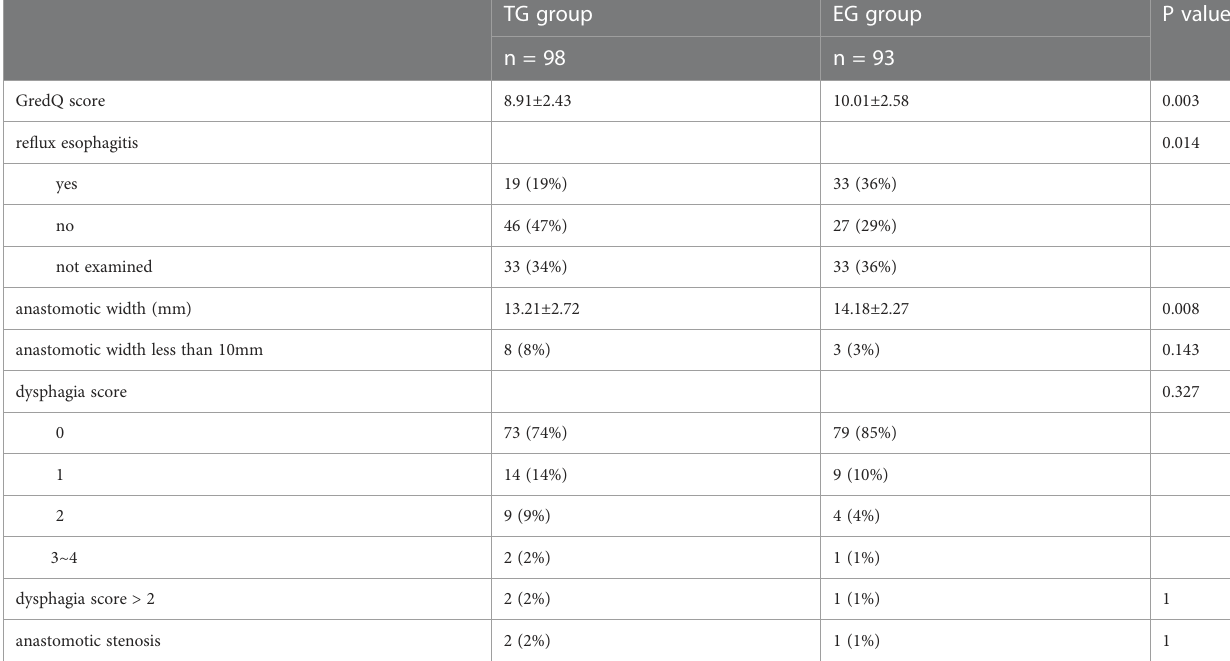
TABLE 5 Postoperative quality of life (1 year after